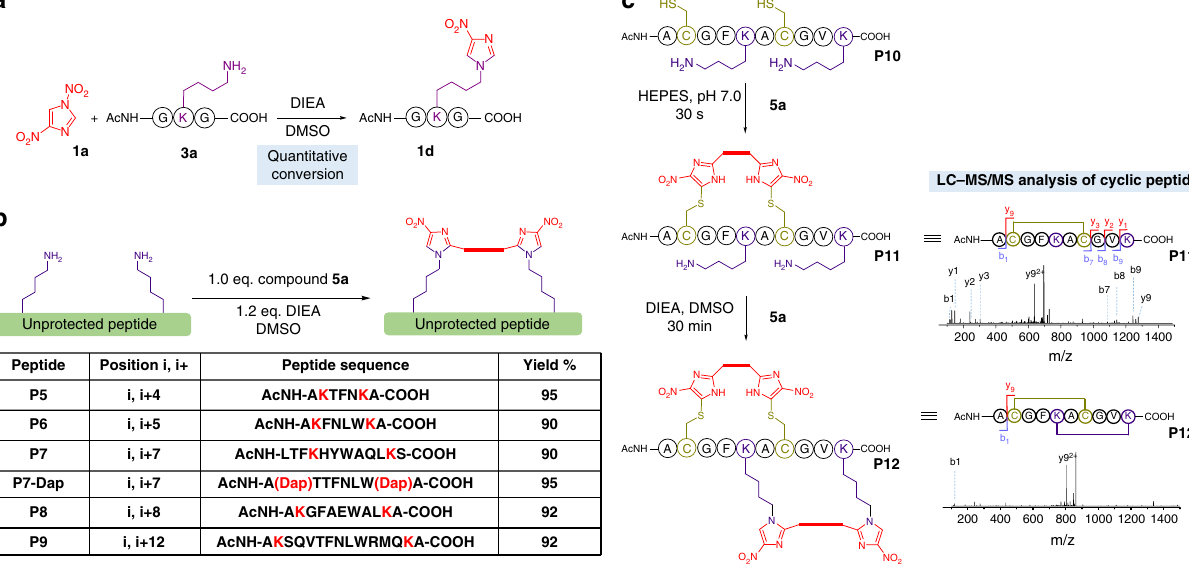
Fig. 6 Macrocyclization of peptides by a bisfunctional 1,4-DNIm through lysine and cysteine crosslinking. a Lysine modi fi cation by 1,4-DNIm 1a . b Peptide macrocyclization by bisfunctional 1,4-DNIm 5a . c Preparation of a bicyclic peptide by controllable sequential macrocyclization by 1,4-DNIm 5a